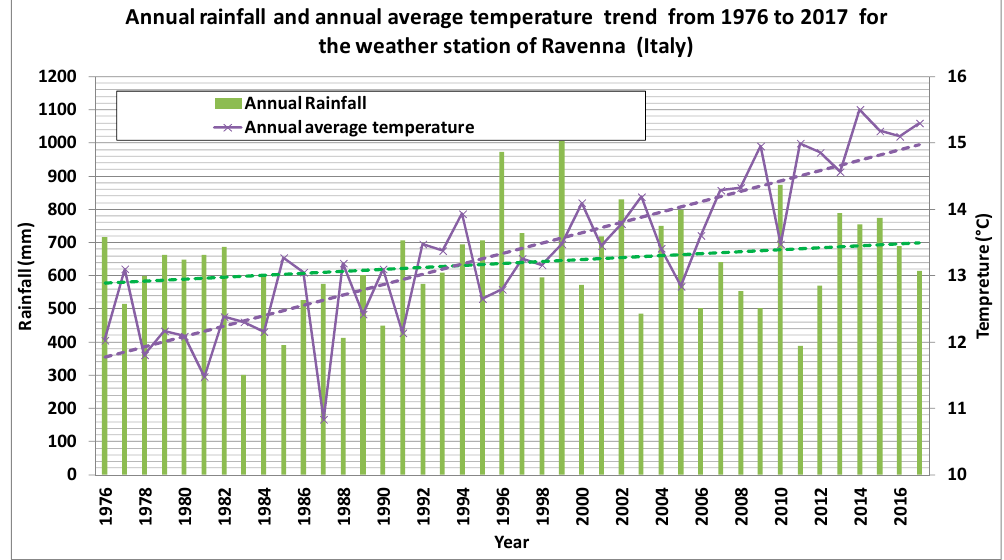
Figure 3. Annual rainfall and average temperature trend from 1976 to 2015 for the weather station of Ravenna (Italy).